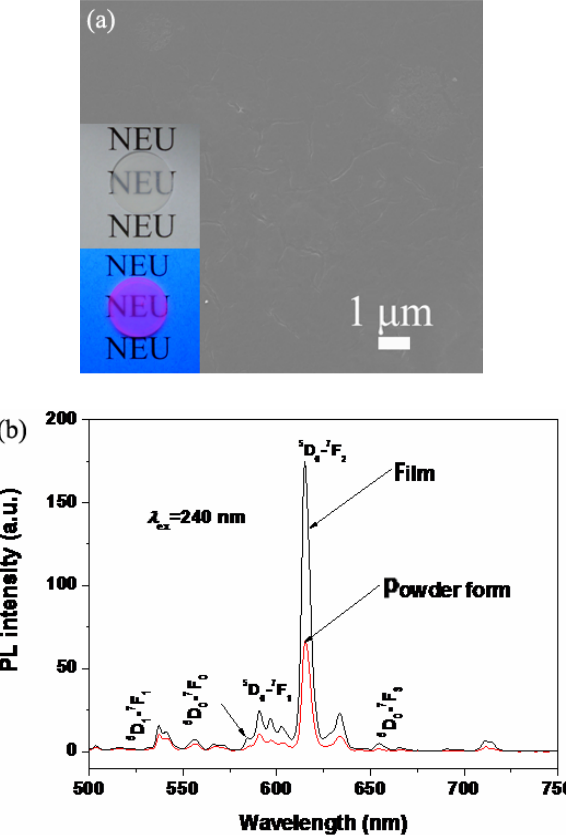
Fig. 7 FE-SEM image of the oriented (Y 0.95 Eu 0.05 ) 2 O 3 film and a comparison of the PL spectra of the powder and film forms. Reproduced with permission from Ref. [25], © National Institute for Materials Science